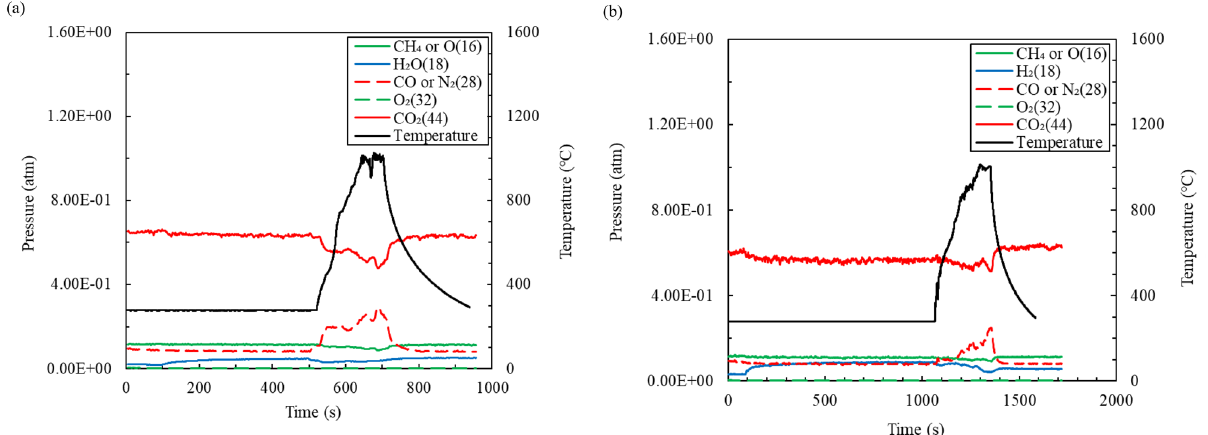
Figure 5. Temperature change and exhaust gas analysis results as a function of time when the mixture is heated with ( a ) a microwave electrical field and ( b ) a magnetic field.